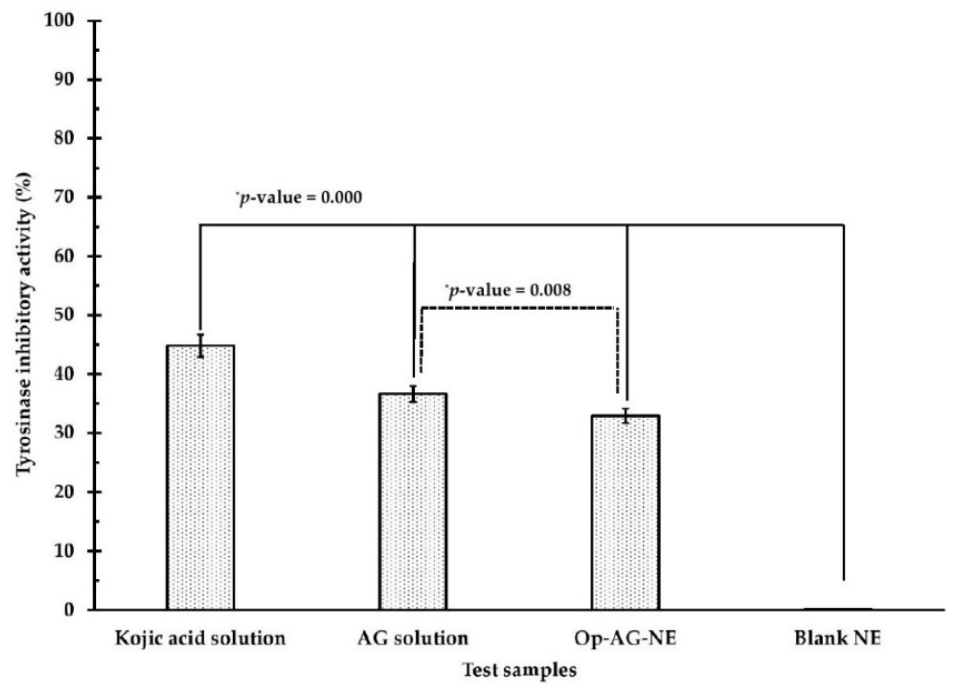
Figure 7. Intracellular tyrosinase inhibitory activity (%) of the test samples in the A375 cells (mean ± SD, n = 3) (* significantly different at a p -value < 0.05).